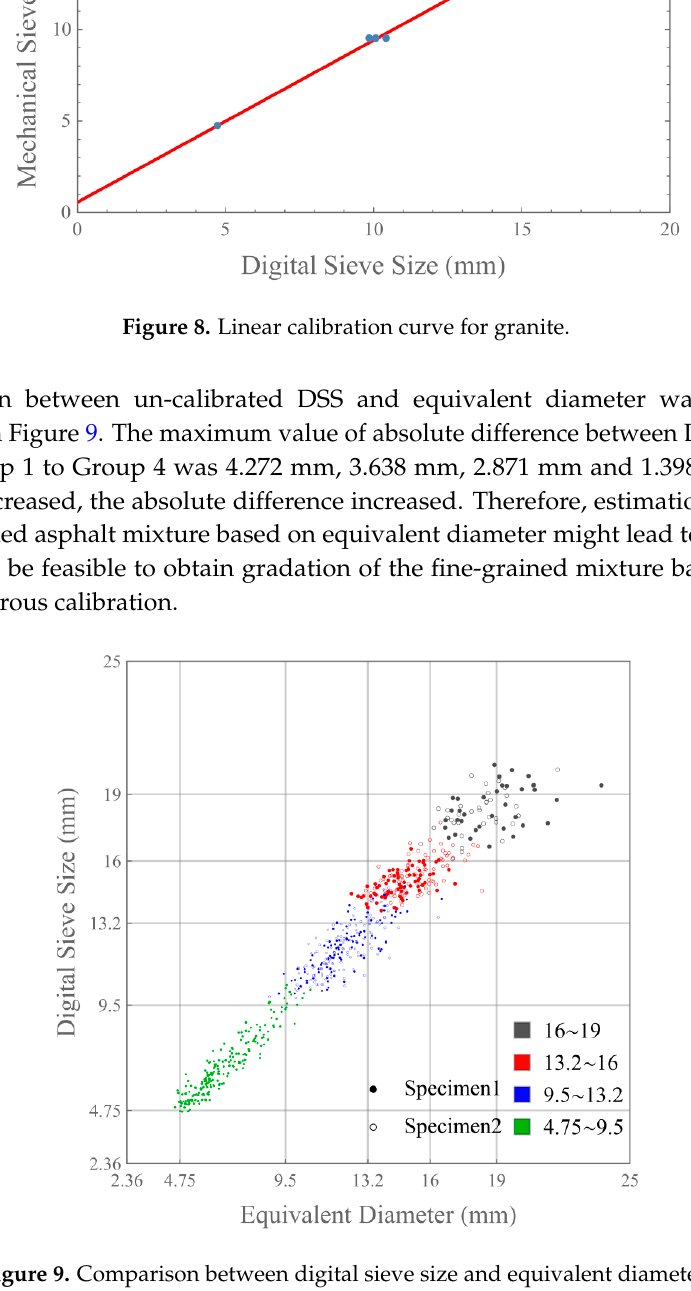
Figure 9. Comparison between digital sieve size and equivalent diameter.